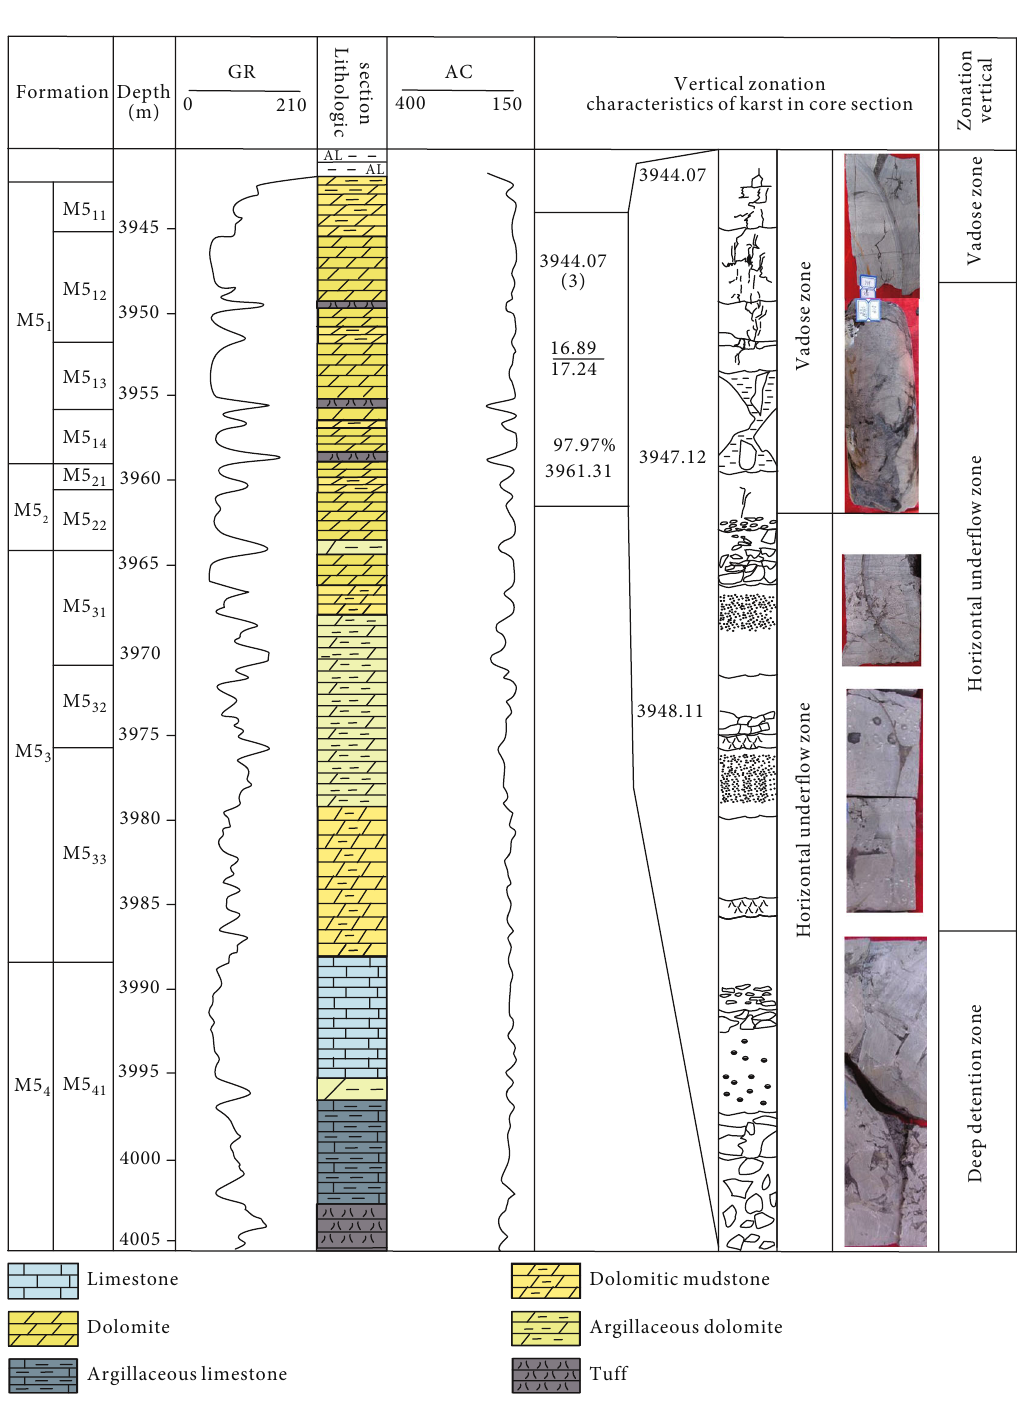
Figure 8: Vertical zonation diagram of ancient karst of well